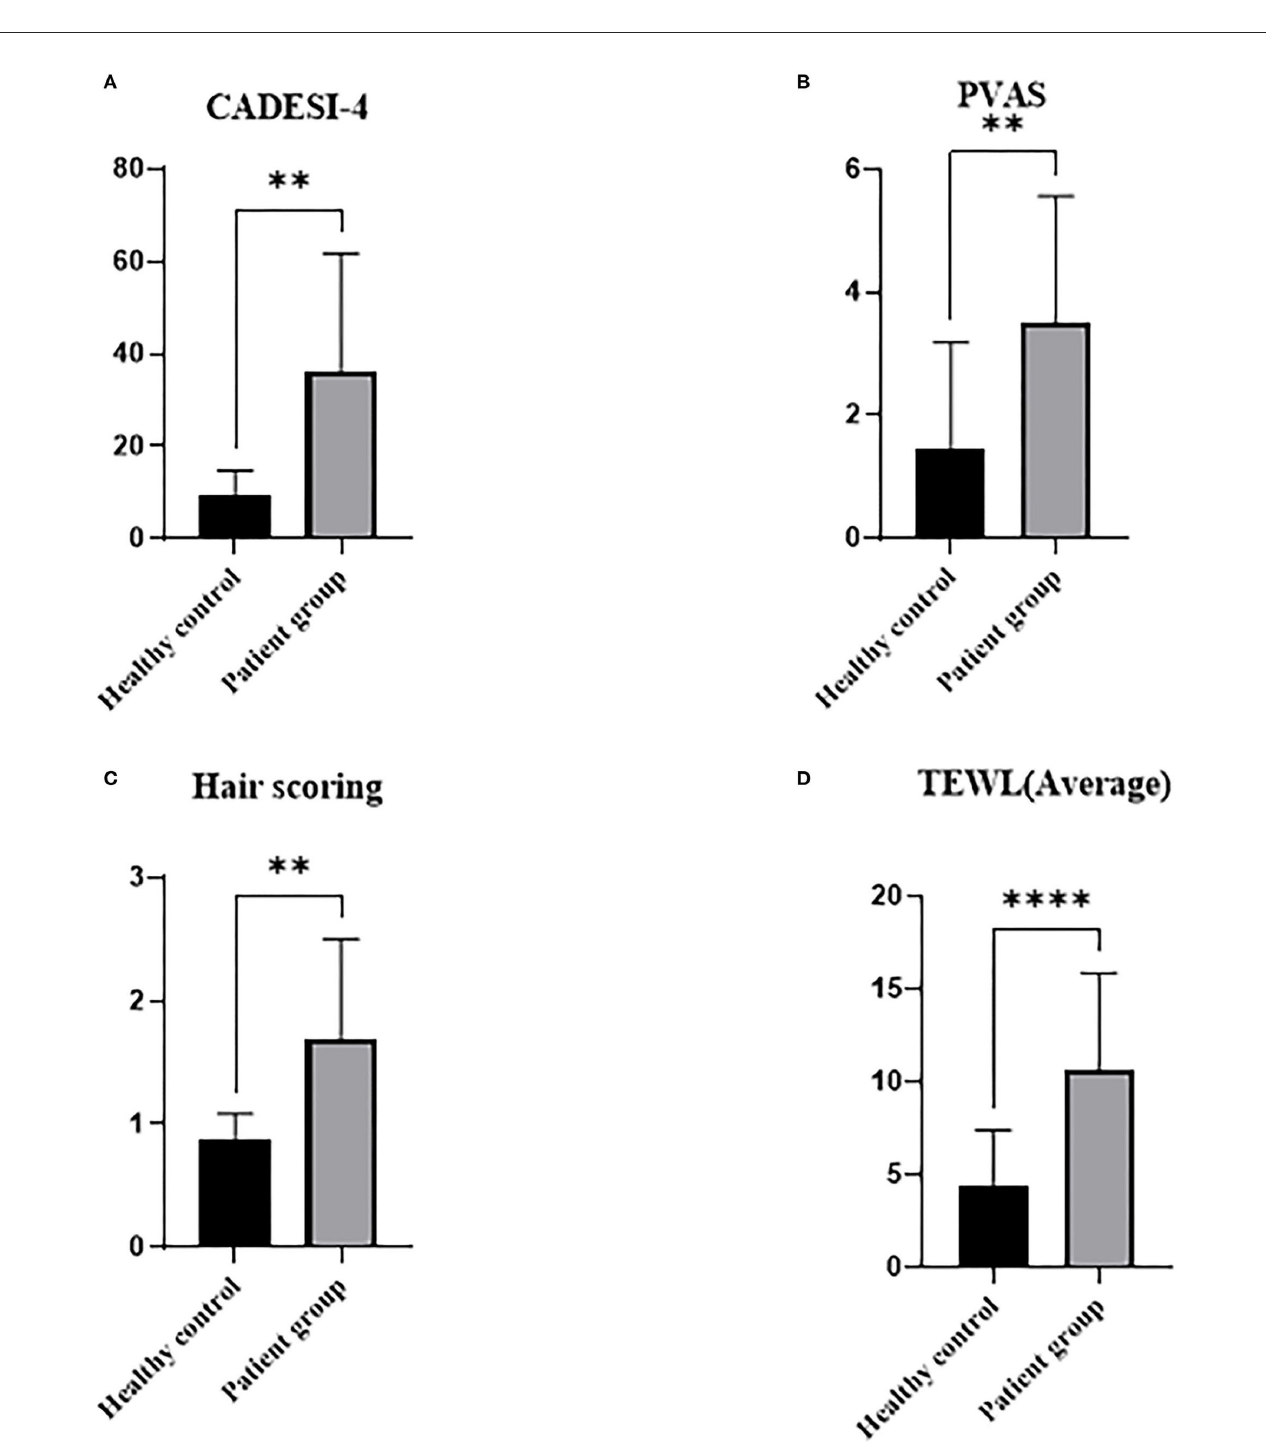
FIGURE1 Graphs of skin and hair conditions by underlying diseases in dogs at starting point. Healthy controls were determined based upon medical history and physical examination. Treatment group includes CAD and PDH. CAD, canine atopic dermatitis; CADESI-04, canine atopic dermatitis extent and severity index-04; PDH, pituitary dependent hyperadrenocorticism; PVAS, pruritus visual analog scale; TEWL, transepidermal water loss. ** p < 0.01, **** p <